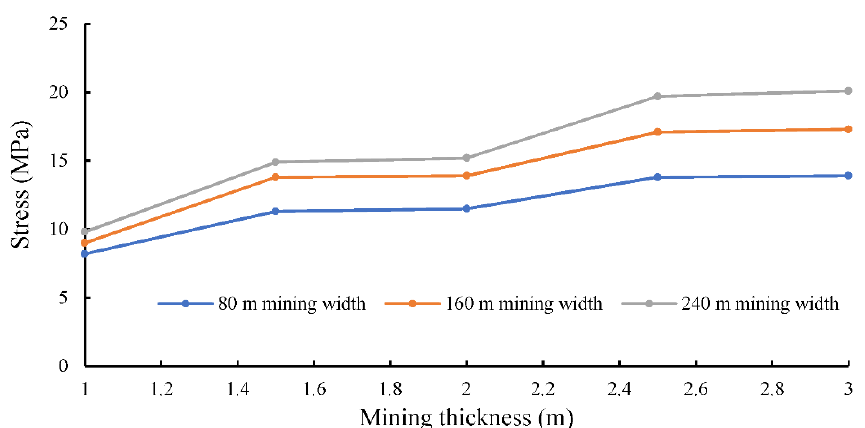
Figure 4. Maximum value of the stress of the backfilled pier-column as a function of mining width and mining thickness.